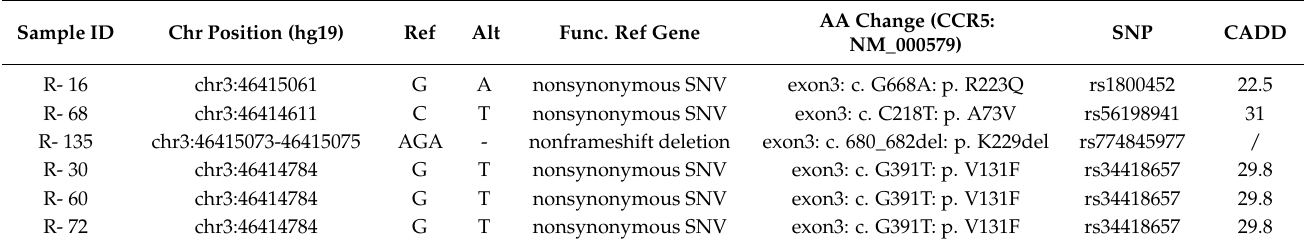
Table 2. Coding variants found in CCR5 .